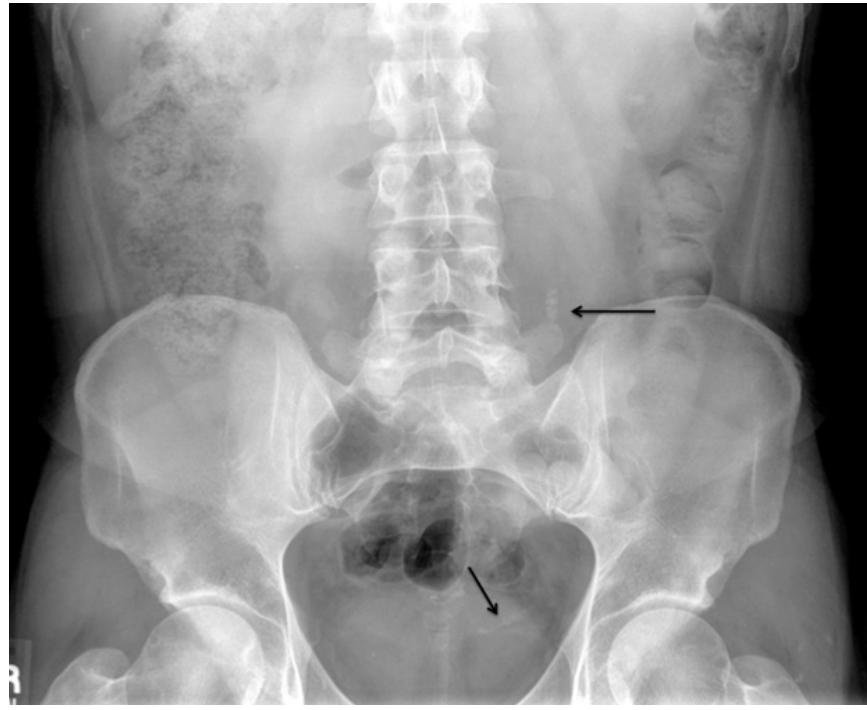
Figure. Steinstrassen seen in the left